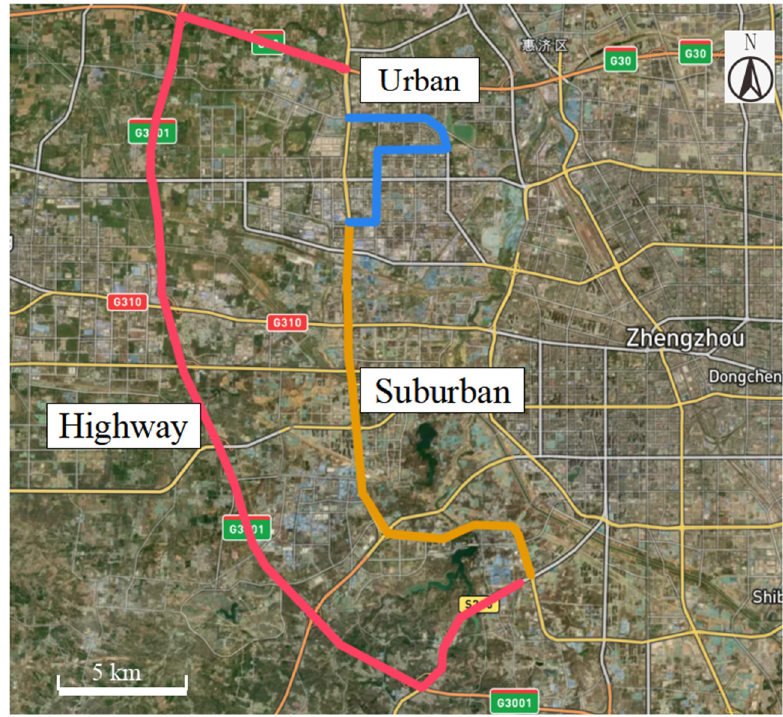
Figure 1. The route used for the real-driving emission tests. (Blue line: the urban road; Yellow line: the suburban road; Red line: the highway road).